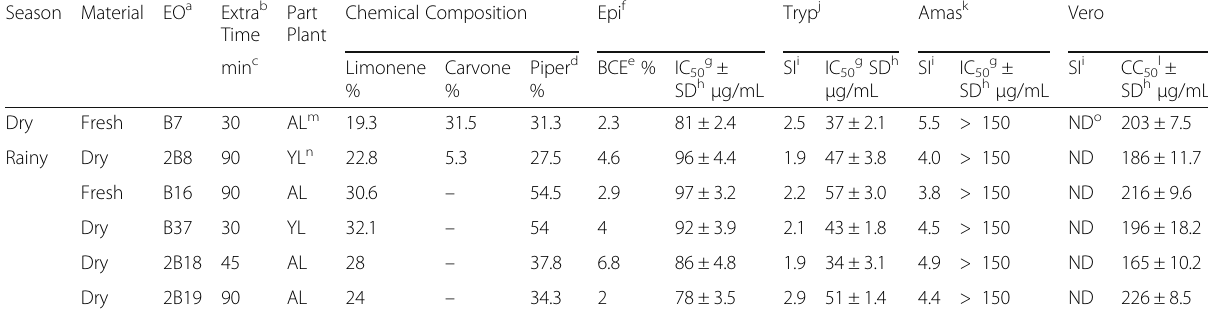
Table 4 Relative chemical composition and anti-proliferative effect on T. cruzi of EOs extracted from the Carvone chemotype of L.